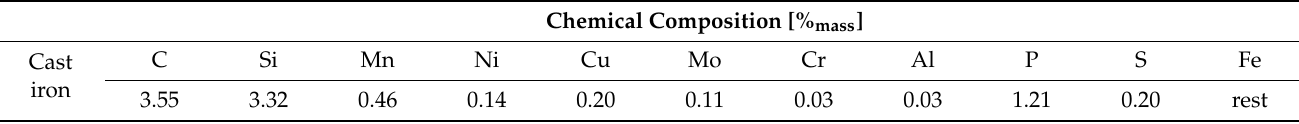
Table 2. Chemical composition of the cast iron used for the test castings. Chemical Composition [% mass ]